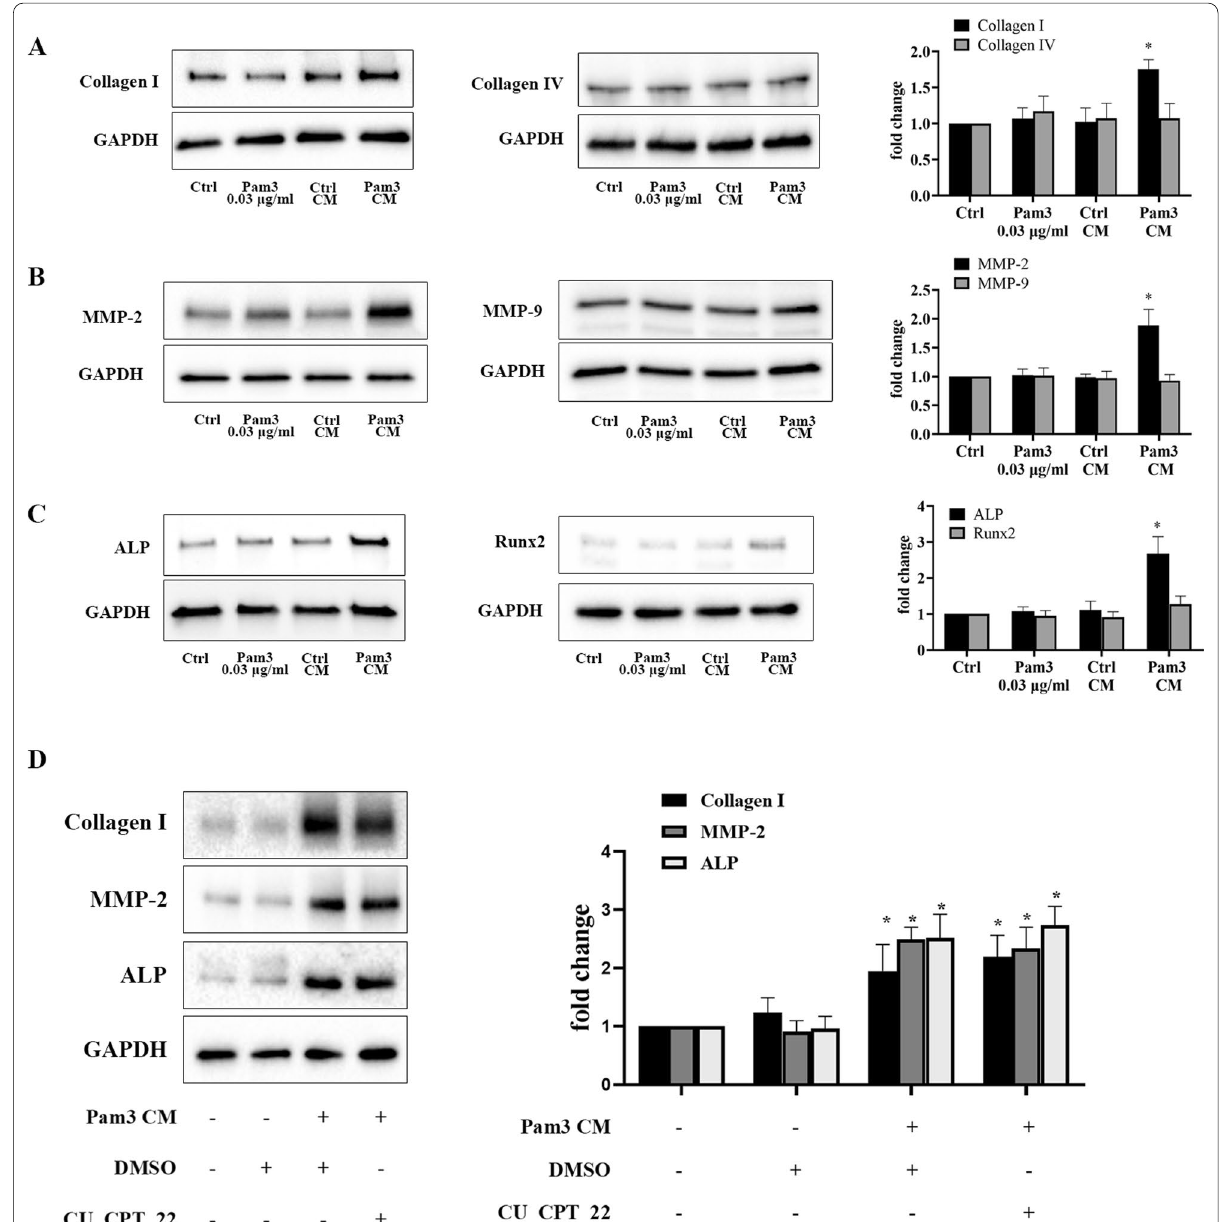
Fig. 2 Pam3 CM up-regulates fibrogenic and osteogenic mediators in AVICs independent of TLR2. A–C AVICs were exposed to Pam3 (0.03 μg/ ml), control CM or Pam3 CM for 48 h. Levels of collagen I, collagen IV, MMP-2, MMP-9, ALP and RUNX2 were determined by immunoblotting. Representative immunoblots and densitometric data show that Pam3 CM selectively up-regulated collagen I, MMP-2 and ALP in AVICs among the fibrogenic and osteogenic factors examined while control CM or a low concentration of Pam3 had no effect. D AVICs were pretreated with TLR2 inhibitor CU CPT 22 (10 µM) or DMSO for 1 h and then exposed to Pam3 CM treatment for 48 h. Inhibition of TLR2 in AVICs did not alter the effect of Pam3 CM on the upregulation of collagen I, MMP-2 and ALP. Data are presented as mean each group. *P < 0.05 vs. untreated